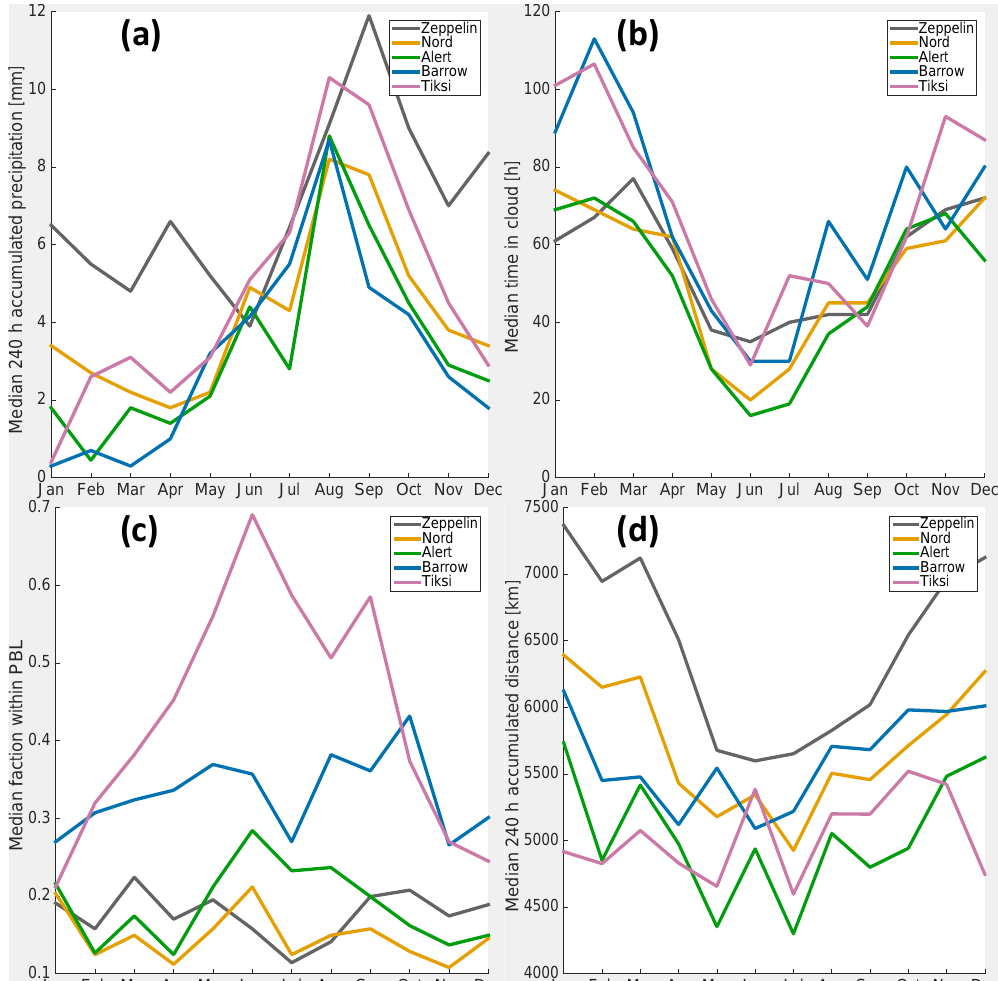
Figure 10. Monthly statistics (median values) of trajectory-derived parameters for all sites. (a) Accumulated precipitation along the 240h back-trajectory. (b) Number of hours in a cloud. This was presumed when the relative humidity was greater than 95%. (c) Fraction of trajectory time within the planetary boundary layer. This was assumed when its altitude above the surface was smaller than twice the model mixing layer height. (d) Trajectory accumulated